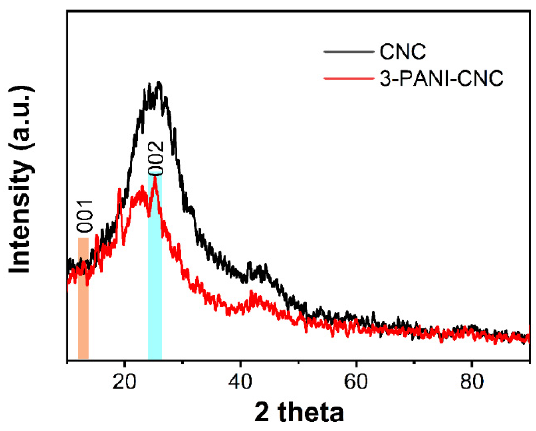
Figure 9. XRD Profiles for the CNC and 3-PANI-CNCs.